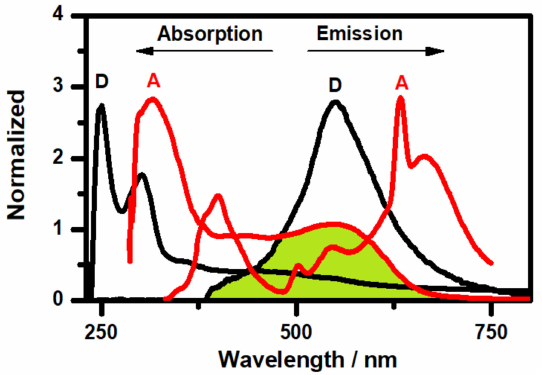
Figure 9. Absorption and emission spectra of G1PPT-co-P3HT (D) and PDI-co-Carbazole (green area represents the spectral overlap of donor emission and acceptor absorption characterizing the Förster resonance energy transfer)